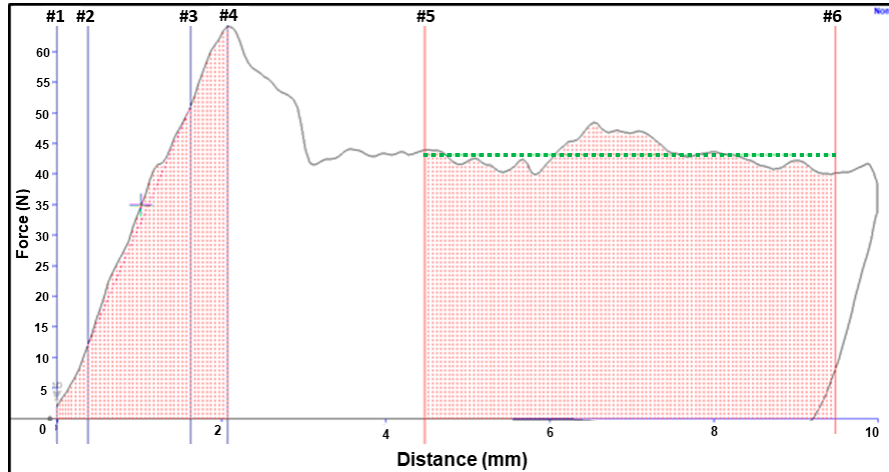
Figure 1. Example of force-distance curve obtained from TA.XT plus Texture Analyzer (Stable Micro Systems Ltd., Godalming, Surrey, UK) resulting from penetration of an unpeeled apple. The TA.XT plus was equipped with an 8 mm cylindrical stainless-steel probe, and operated to a depth of 10 mm at a speed of 10 mm/s. The parameters used for interpretation of the curves are described in Table 1, using the anchor numbers located along the upper edge of the diagram. The macro used for calculation of the parameters is presented in Table S1.